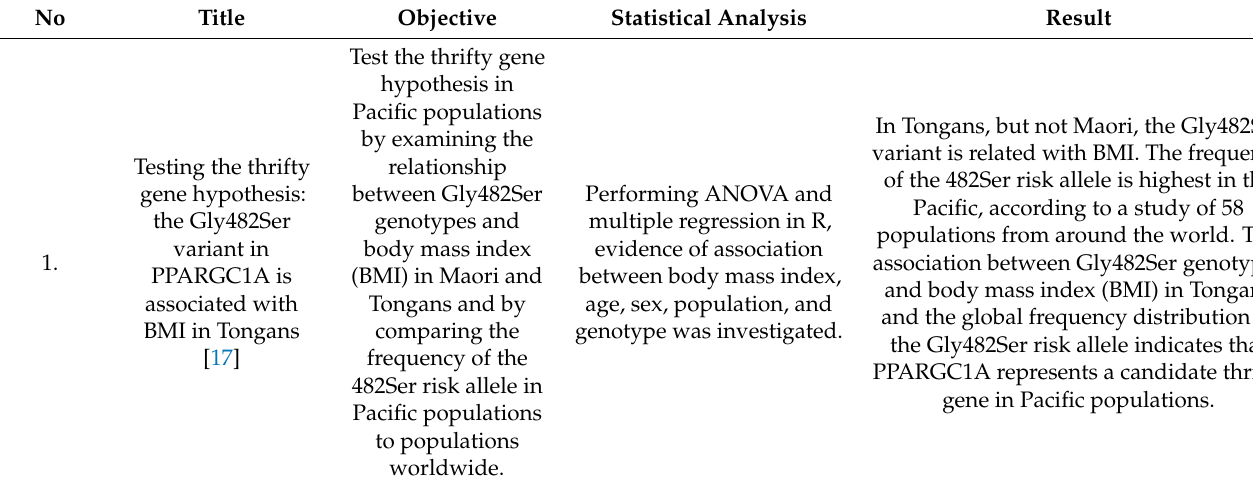
Table 2. Research objectives and results of included